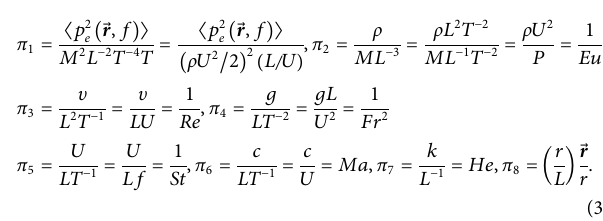
Table 1. Among them, Ref. [30] is a “ water drop ” submarine with